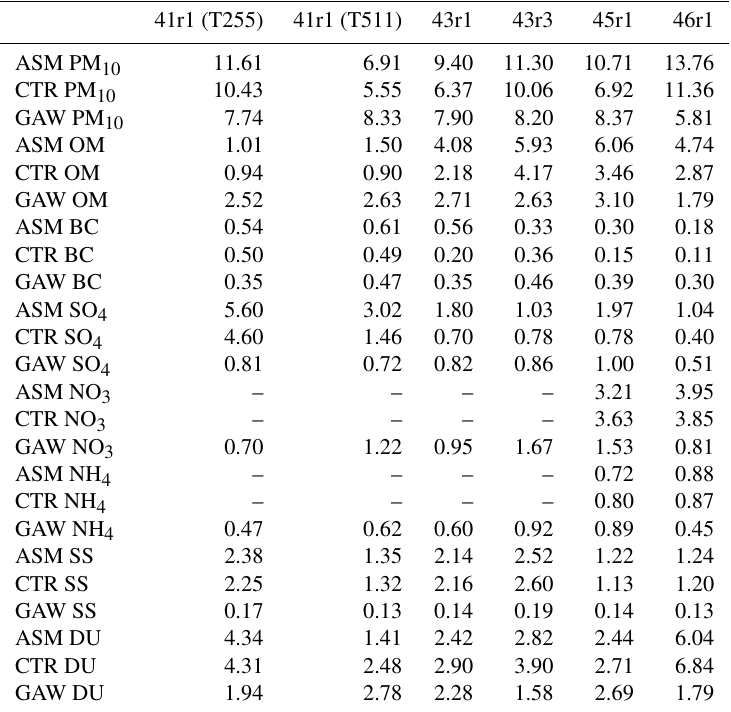
Table 3. Concentrations [µg/m 3 ] of IFS-AER prognostic aerosols by ASM and CTR versus GAW in situ measurements at the Hohenpeißen- berg station, averaged over constant model configuration periods as defined in Table